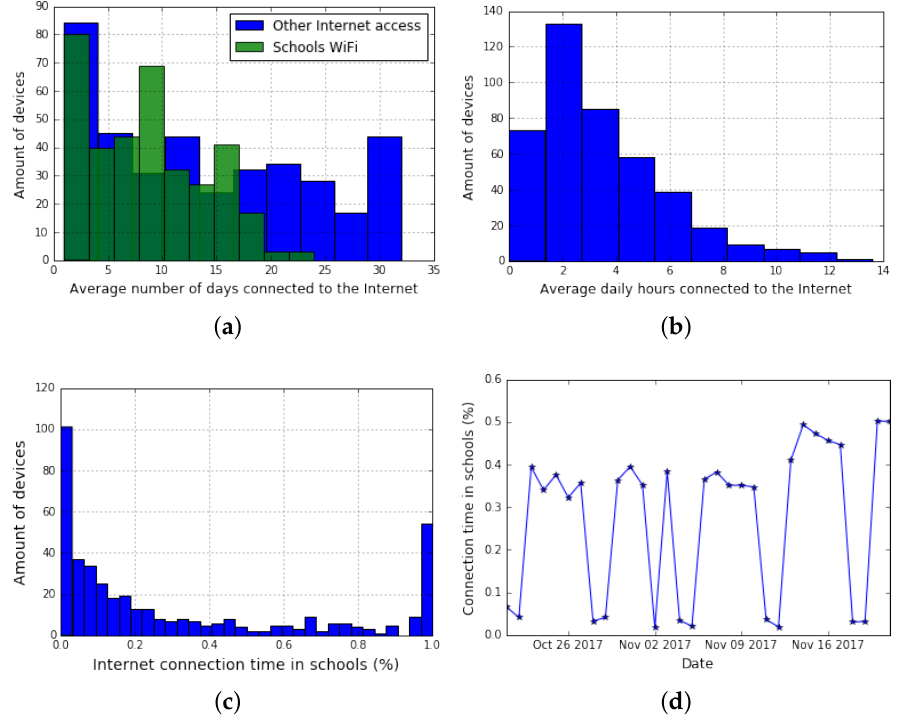
Figure 7. Use by location example. ( a ) Average number of connected days. ( b ) Average connected hours per day. ( c ) Percentage of at school connection time. ( d ) Percentage of at school connection time by